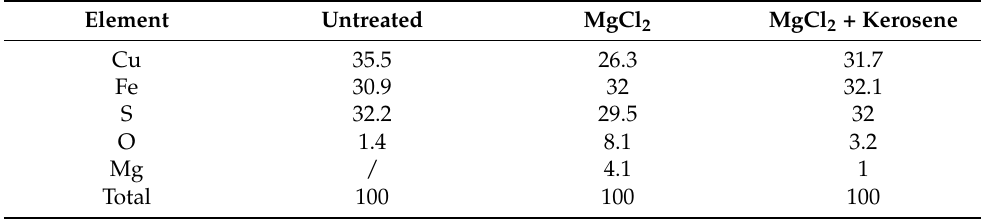
Figure 5. SEM images of chalcopyrite surfaces under different conditions: ( a ) untreated chal- copyrite; ( b ) chalcopyrite treated in 0.05 M MgCl 2 solution at pH 10; ( c ) 0.05M MgCl 2 + 400 ppm kerosene solution at pH 10. Table 1. Elemental composition (wt %) of chalcopyrite surface under different conditions.